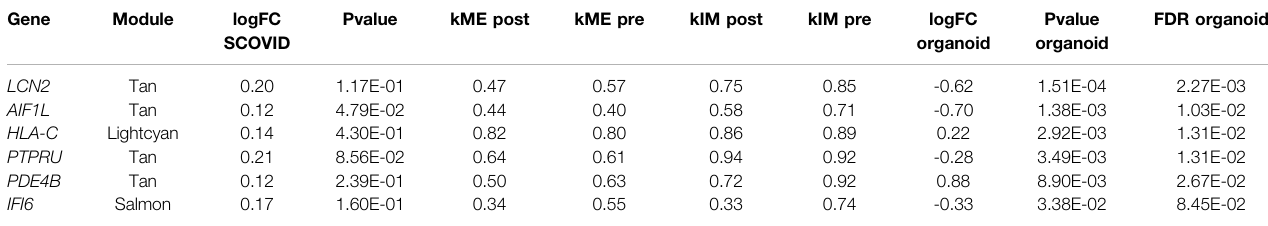
TABLE 4 | Hub genes in non-preserved modules which are also differentially expressed in adult normal mucosa organoids from re-analysis of Fernandez-Barral et al. (FB- ANMO). Gene